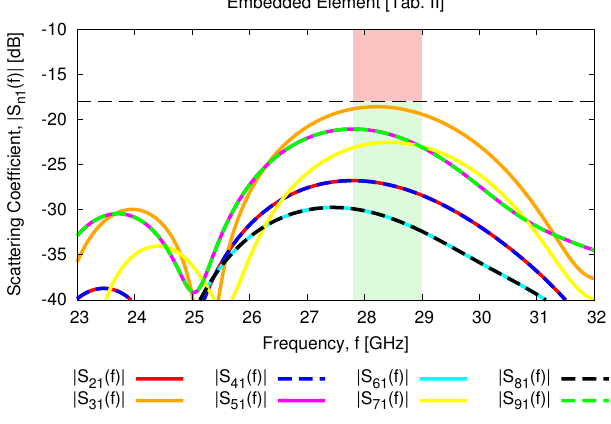
Figure 5. Single embedded element assessment ( gain pattern along the ( a ) azimuthal (i.e., φ = 0 deg) and ( b ) the elevation (i.e., θ = 90 deg) planes.